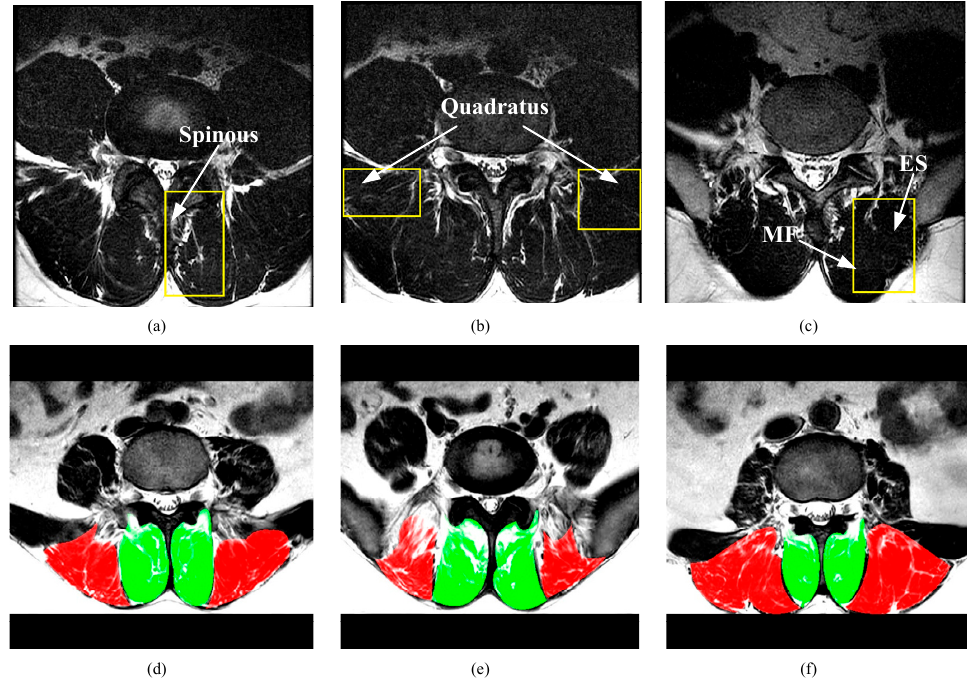
Figure 2. Typical paraspinal muscle Magnetic Resonance (MR) images and their difficulty in segmentation. ( a – c ) show images of three patients whose target muscles are unclear. Yellow rectangular boxes indicate the area that is easily segmented incorrectly. The spinous processes in ( a ), the quadratus in ( b ), and the unobvious boundaries between MF and ES in ( c ) e ff ect the segmentation of the target. ( d – f ) show three slices from di ff erent spinal levels in the same patient. Green denotes the MF muscle and red denotes the ES muscle. Both the MF muscle and the ES muscle have a pronounced